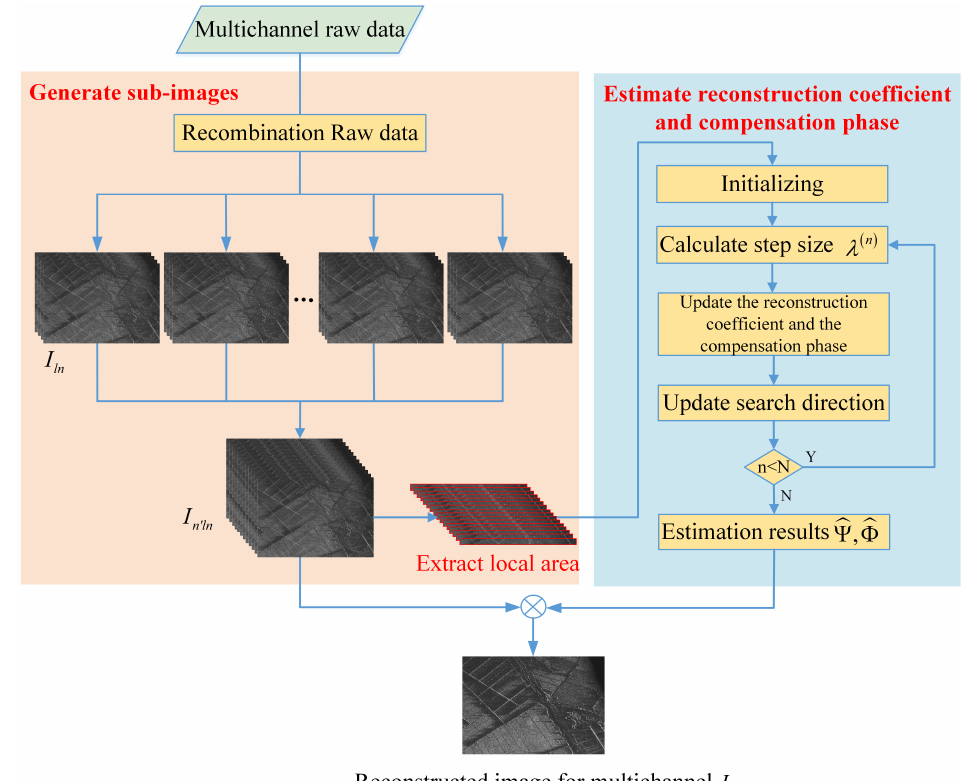
Figure 4. The flow of